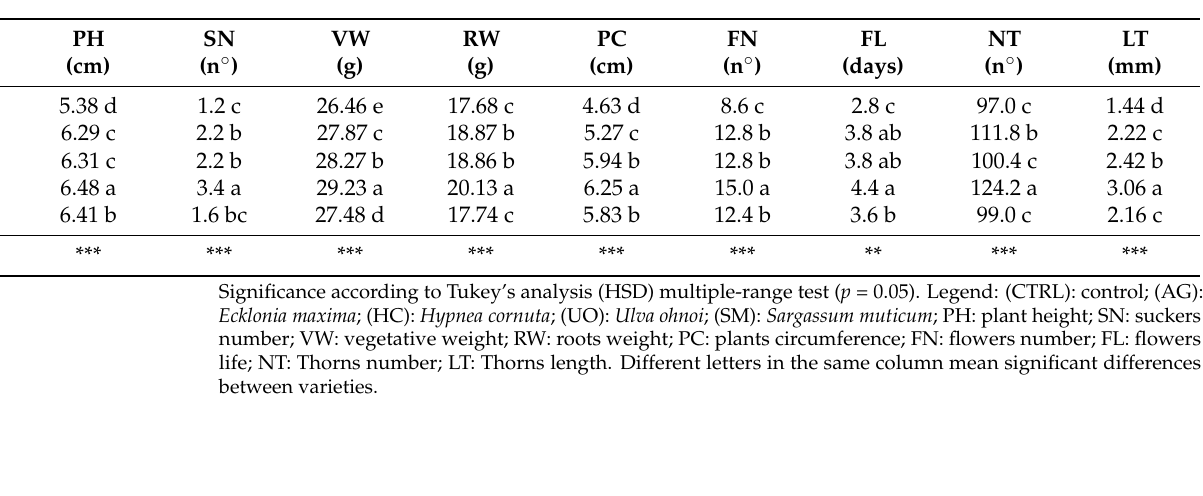
Table 3. Evaluation of liquid seaweed fertiliser on agronomic characters of Mammillaria glassii